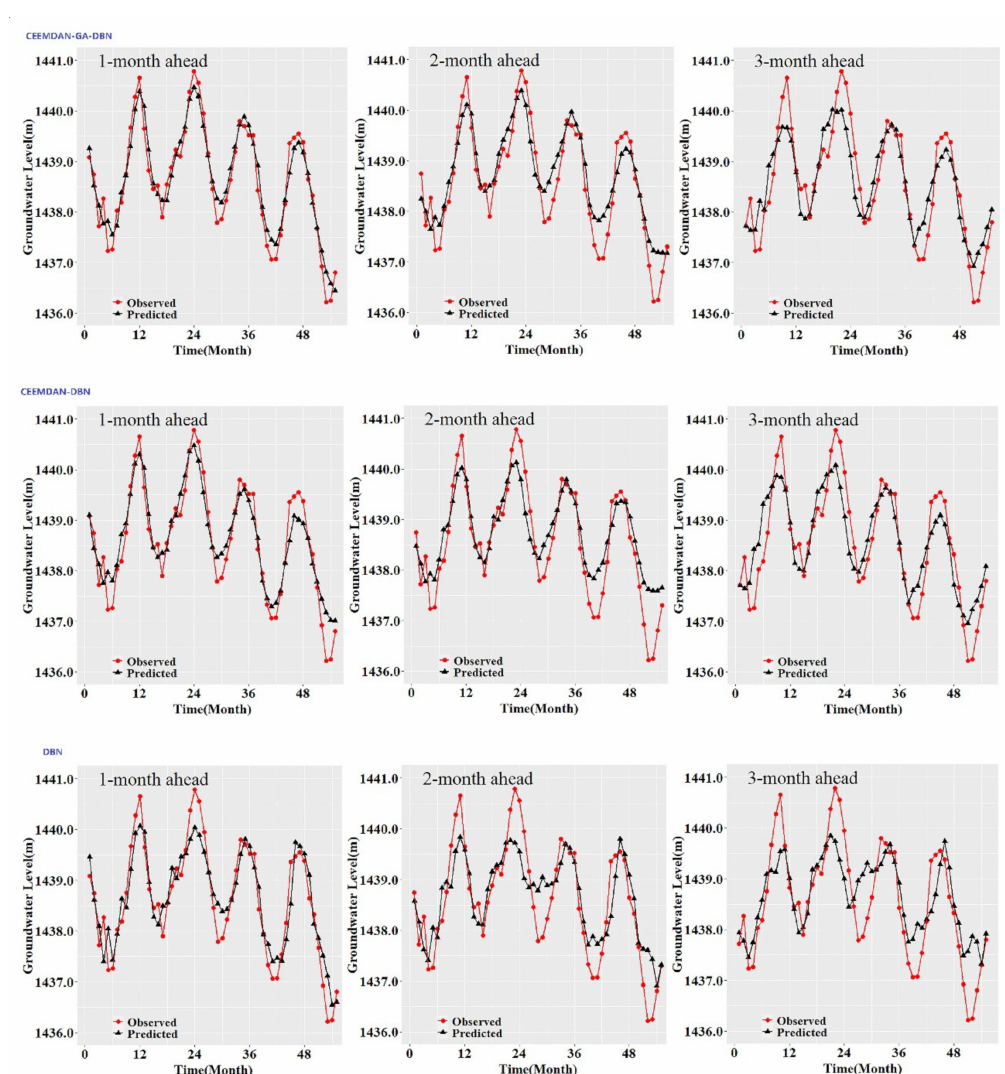
Figure 5. Observed vs. predicted groundwater level for Well II generated by the CEEMDAN-GA-DBN, CEEMDAN-DBN and DBN models for 1-, 2- and 3-month ahead forecast in the testing period.